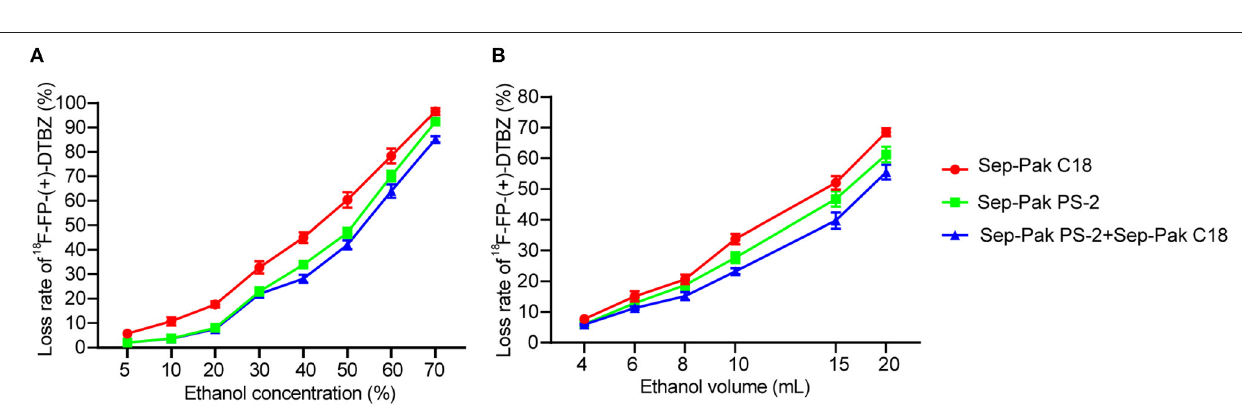
Frontiers in Medicine |